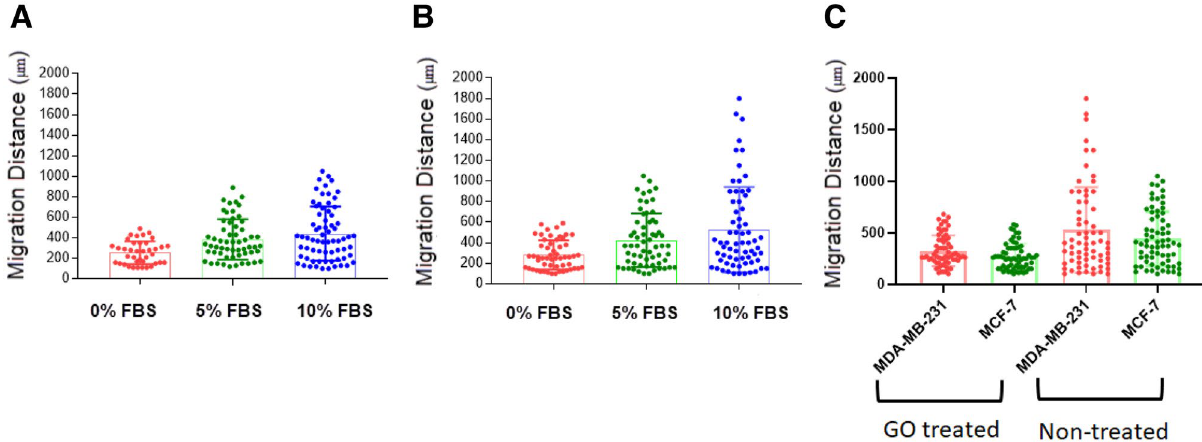
Figure 2. ( A ) The box plot of cell migration of MCF-7 and ( B ) MDA-MB-231 cell lines and ( C ) The cell migration of both cell lines in untreated and treated by the GO nanosheets. Each spot represents one cell in a microfluidic chip, which was obtained from five different independent